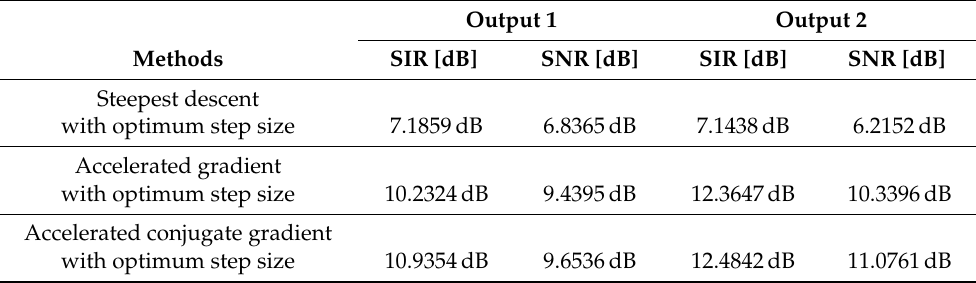
Table 1. Second order BSS in a simulated room environment with two speech sources, noise, and three microphones for the dominant speech output detected by the kurtosis. The SNR is 0dB.